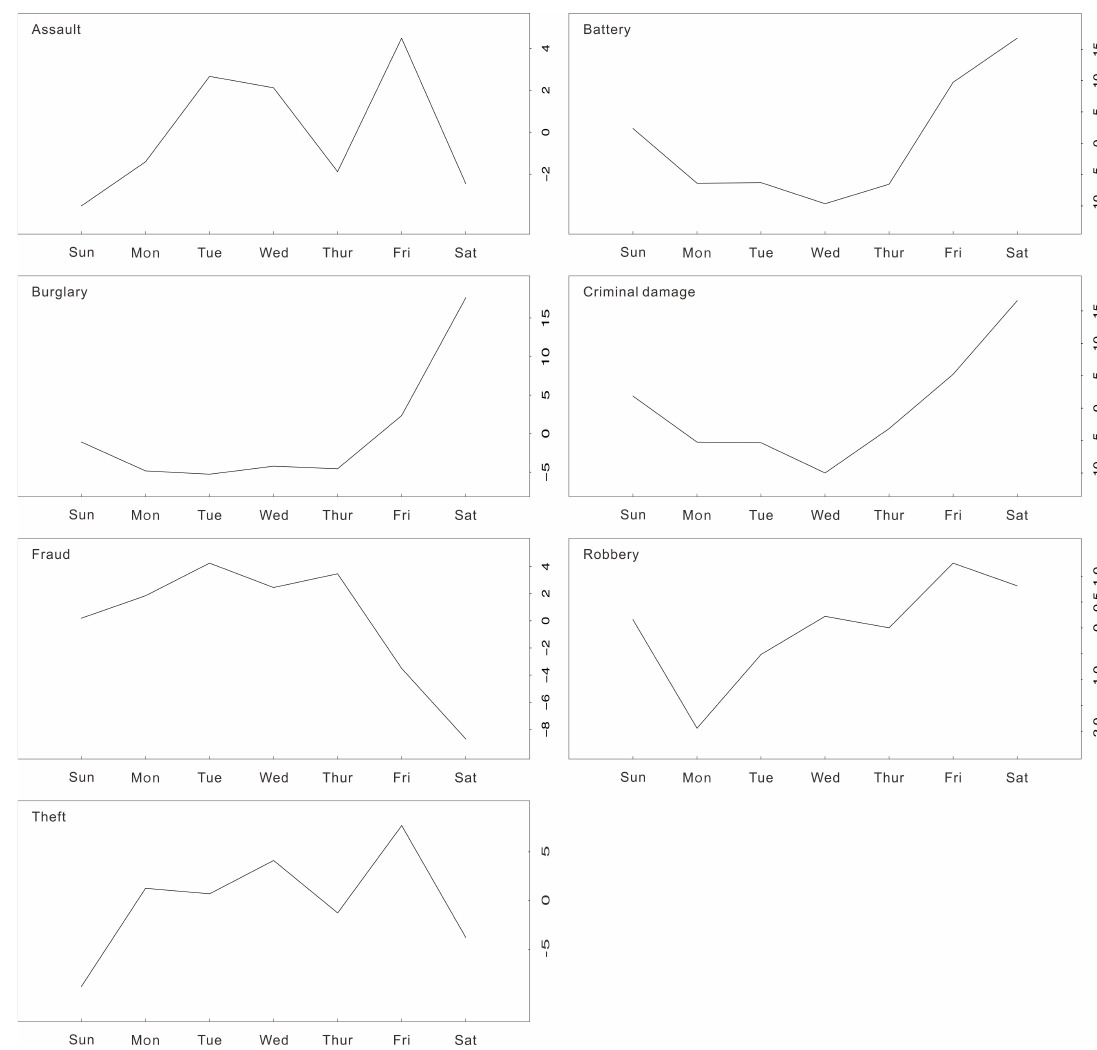
Figure 5. A week variation in the seasonal component. It shows the weekly cyclical variation of different types of crimes in